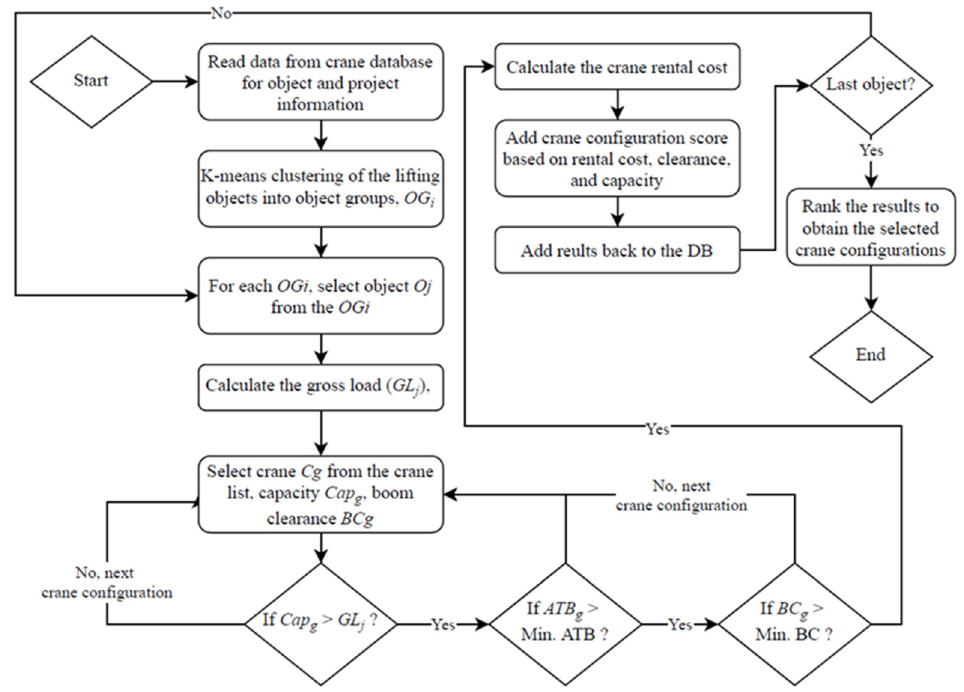
Figure 4. Heuristic search approach for crane configuration selection.